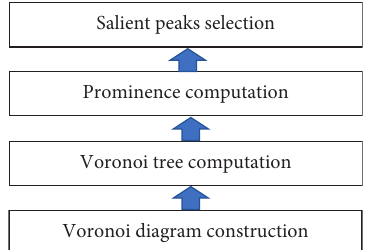
Figure 1: The main steps of the proposed method.